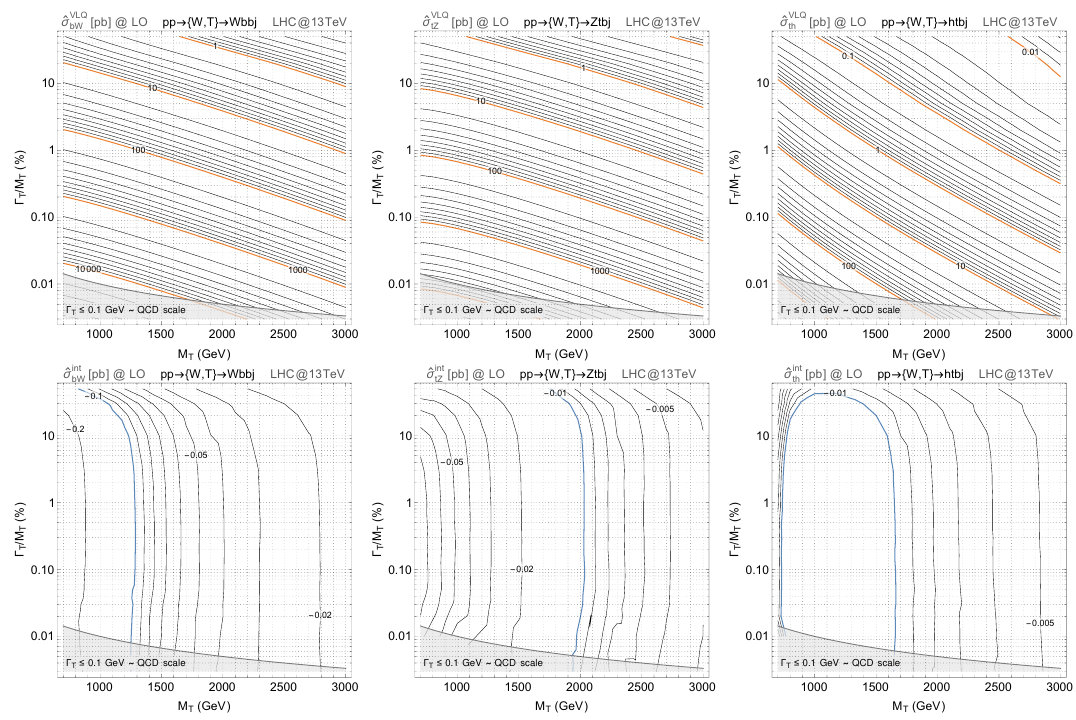
Figure 18 . Values of the ˆ σ VLQ (top row) and ˆ σ int (bottom row) bare cross sections, in pb, for the pp → Wbbj (left), Ztbj (centre) and Htbj (right) processes. We consider 13 TeV LHC proton- proton collisions and present the results in the ( M